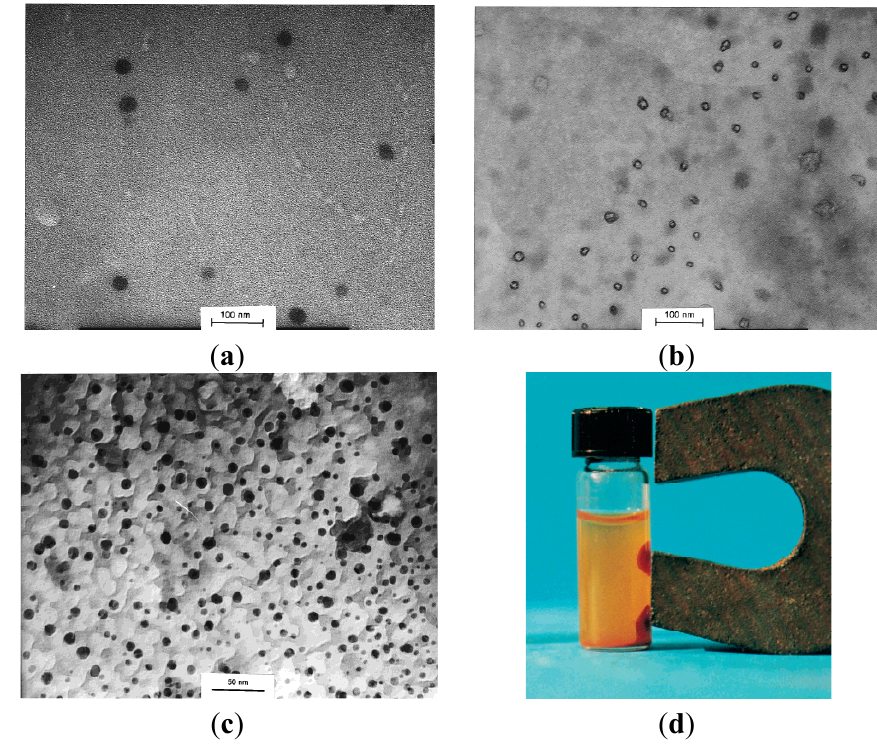
Figure 17. TEM images for PI- b -PCEMA- b -PtBA nanospheres at each step of the synthesis: ( a ) after PCEMA cross-linking and PI hydroxylation (stained with OsO of the tert -butyl groups (stained with OsO ( d ) attraction by a magnet. Adapted with permission from [40]. Copyright 2000 American Chemical